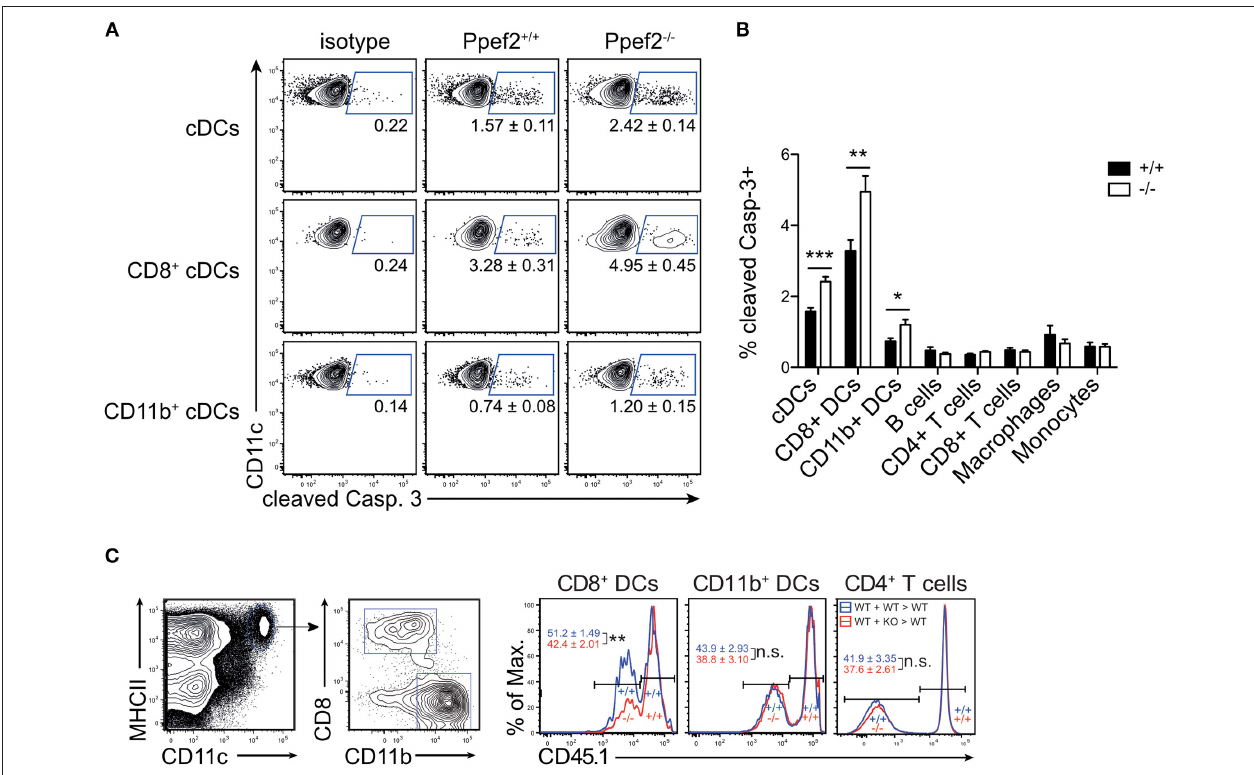
FIGURE 4 | Ppef2-deficiency causes increased levels of cleaved caspase-3 in DCs. (A) Splenocytes were stained intracellularly for cleaved caspase-3 and analyzed by flow cytometry. Shown are representative FACS-plots of two experiments with similar outcome ( n = 4 each). The corresponding statistics of the pooled data ( n = 8) are shown in (B) together with the statistical analysis of other cell types. Statistical analysis was performed using Student’s t -test, with * p < 0.05; ** p < 0.01; *** p < 0.001. (C) Mixed bone marrow chimeras were produced by irradiation of CD45.1 + recipients and reconstitution with a 1:1 mix of Ppef2 + / + (CD45.1 + ) and Ppef2 + / + (CD45.2 + ) bone marrow ( + / + : + / + > + / + ), or a 1:1 mix of Ppef2 + / + (CD45.1 + ) and Ppef2 − / − (CD45.2 + ) bone marrow ( + / + : –/– > + / + ). Mixed bone marrow chimeras were analyzed 8–10 weeks after reconstitution by gating on CD11c + MHCII + CD8 + CD11b − cDC1, CD11c + MHCII + CD8 − CD11b + cDC2, CD4 + TCR β + T cells and CD45.1. Shown are representative FACS-plots of three independently performed experiments with similar outcome ( n = 11) and statistical analysis was performed using Student’s t -test, with ** p <